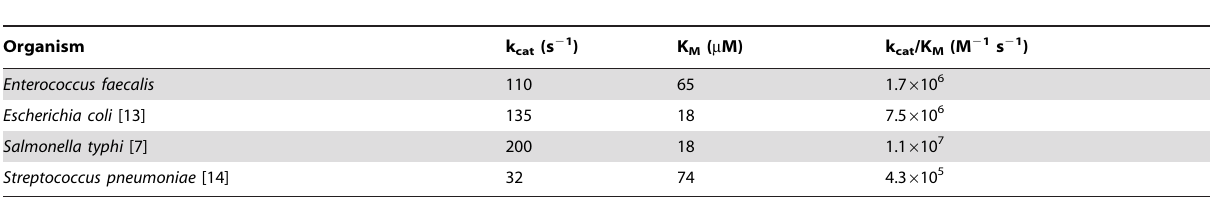
Table 2. Kinetic parameters of various